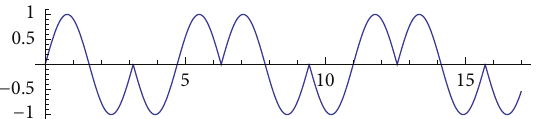
Figure2: 𝑥 󸀠 (𝑡) = 2| sin (𝑡)| cos (𝑡) and hence 𝑥 󸀠󸀠 (𝑡) isnot a continuous